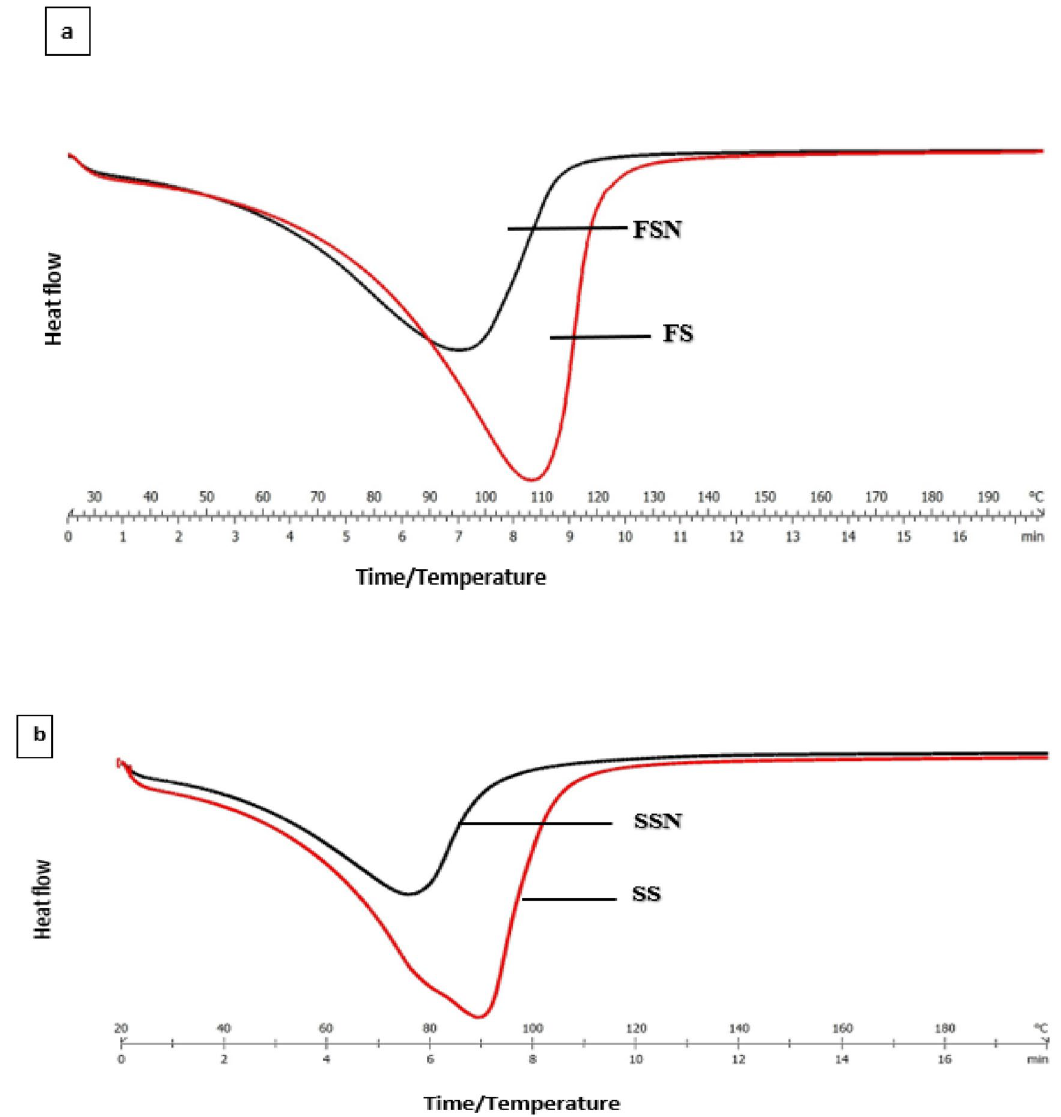
Figure 4. (a,b) Thermographs of native and nano- reduced starch samples. FS, FSN, SS and SSN represent native foxtail millet starch, nano foxtail millet starch, native sorghum starch and nano sorghum starch,